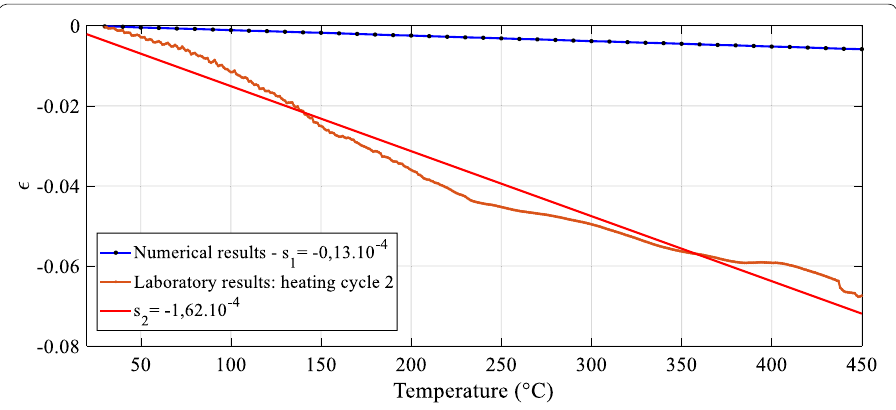
Fig. 10 Comparison of simulated and laboratory CWI measurements. We represent the CWI measurements obtained in the laboratory (orange line) during the second heating cycle of Westerly Granite and in the simulation (blue line) with temperature measured at the middle of the sample. Relative time delays are measured by the “ stretching technique ” when comparing the waveform recorded at a given temperature with respect to the “ reference” waveform. A linear regression is fitted to the measurements to estimate the slopes s 1 and s 2 (blue line and red line for simulated and laboratory results,